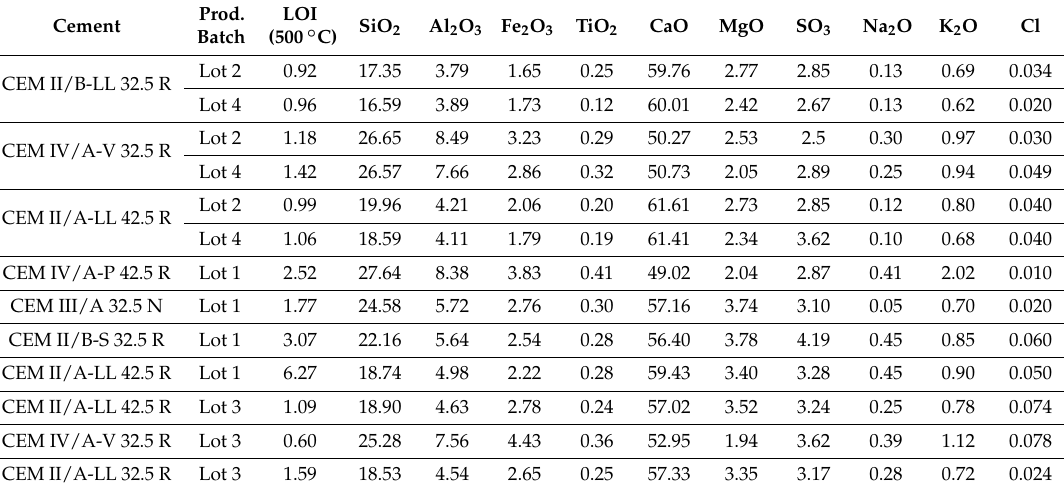
Table 1. Chemical composition (% by mass) of the cements.